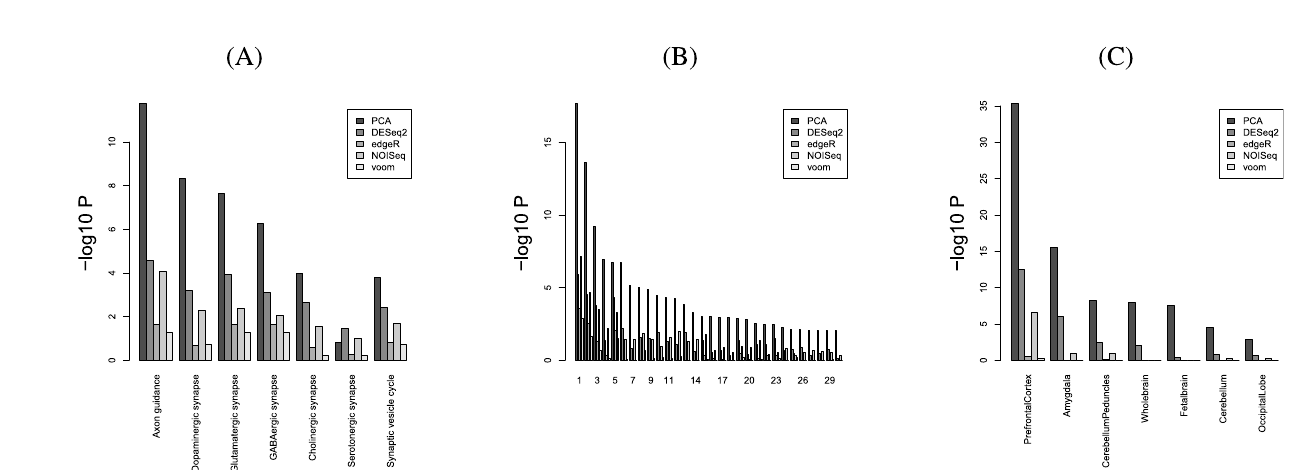
Figure 13. Enrichment analysis for MAQC with other methods in Enrichr (A) KEGG (B) GO BP (C) Human gene atlas. Numbers in (B) correspond to 1. “axonogenesis,” 2. “axon guidance,” 3. “axon